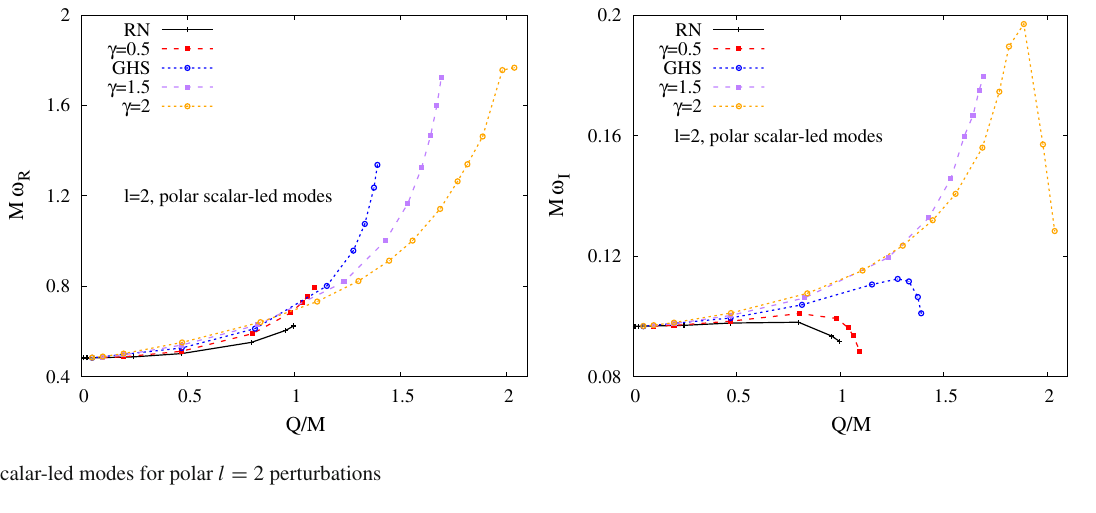
Fig. 5 Scalar-led modes for polar l = 2 perturbations